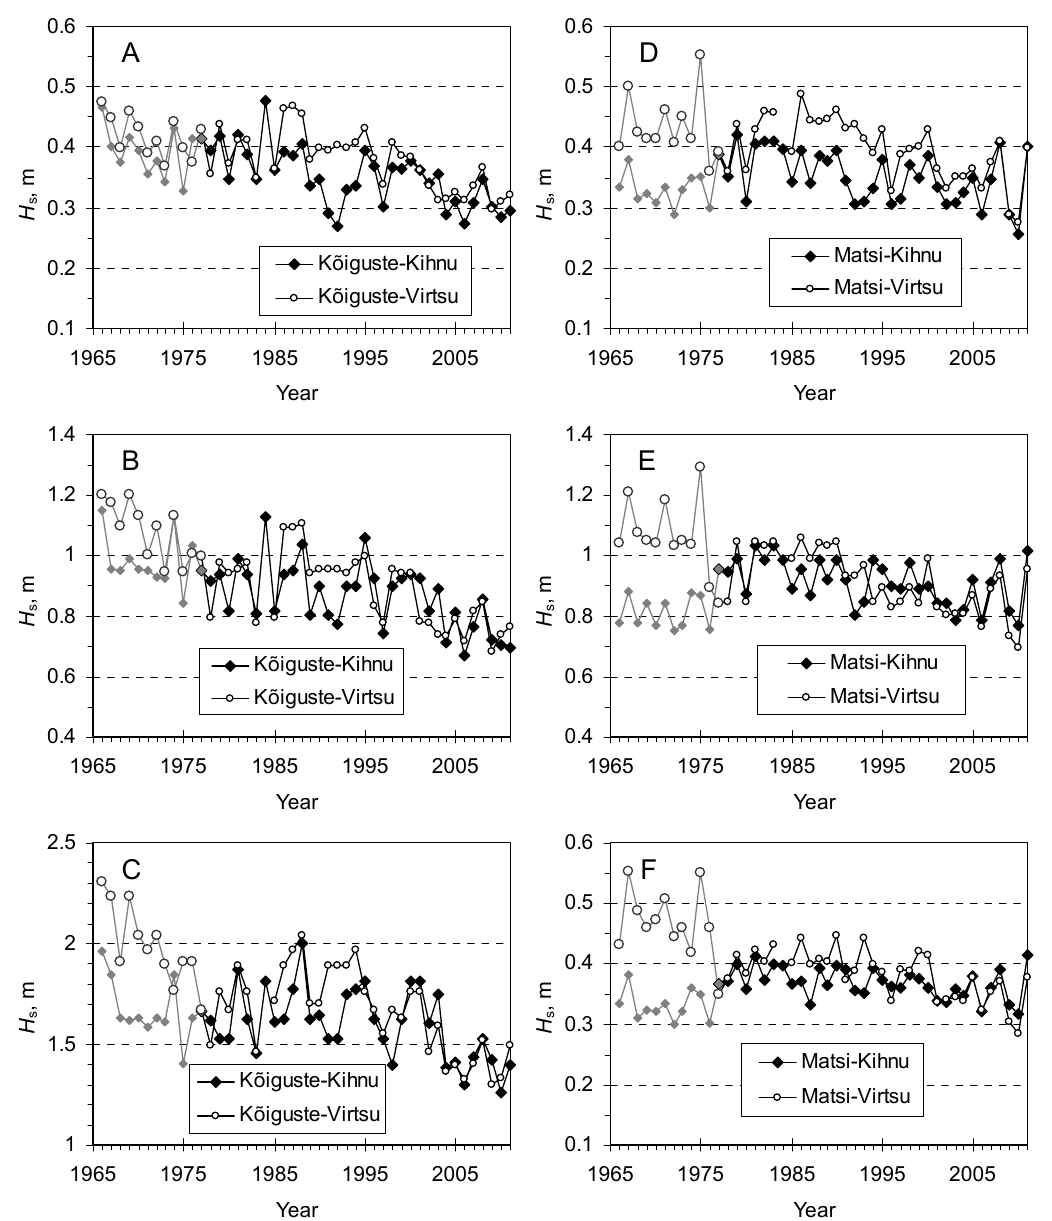
Fig. 4. Hindcasts of significant wave height ( H S ) at Kıiguste and Matsi obtained with two different wind forcings (Virtsu and Kihnu). The time series composed from statistics of annual data samples represent annual average wave heights (A, D), 90%-iles (B, E), 99%-iles (C), and standard deviations (F). The years 1966(cid:150)1976 are probably less